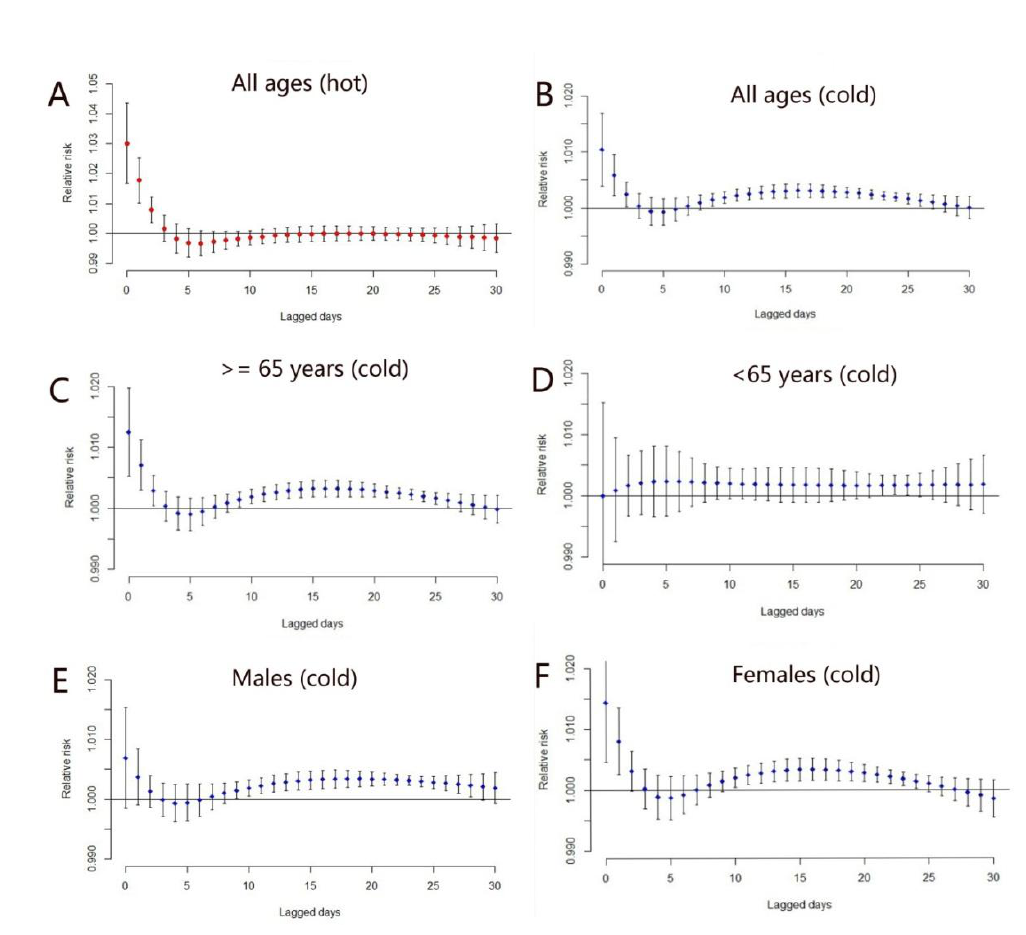
Figure 4. The distributed lag period of heat-related mortality for all ages ( A ); The distributed lag period of cold-related mortality for ( B ) all ages, ( C ) those ≥65 years, ( D ) those <65 years, ( E ) males, and ( F )